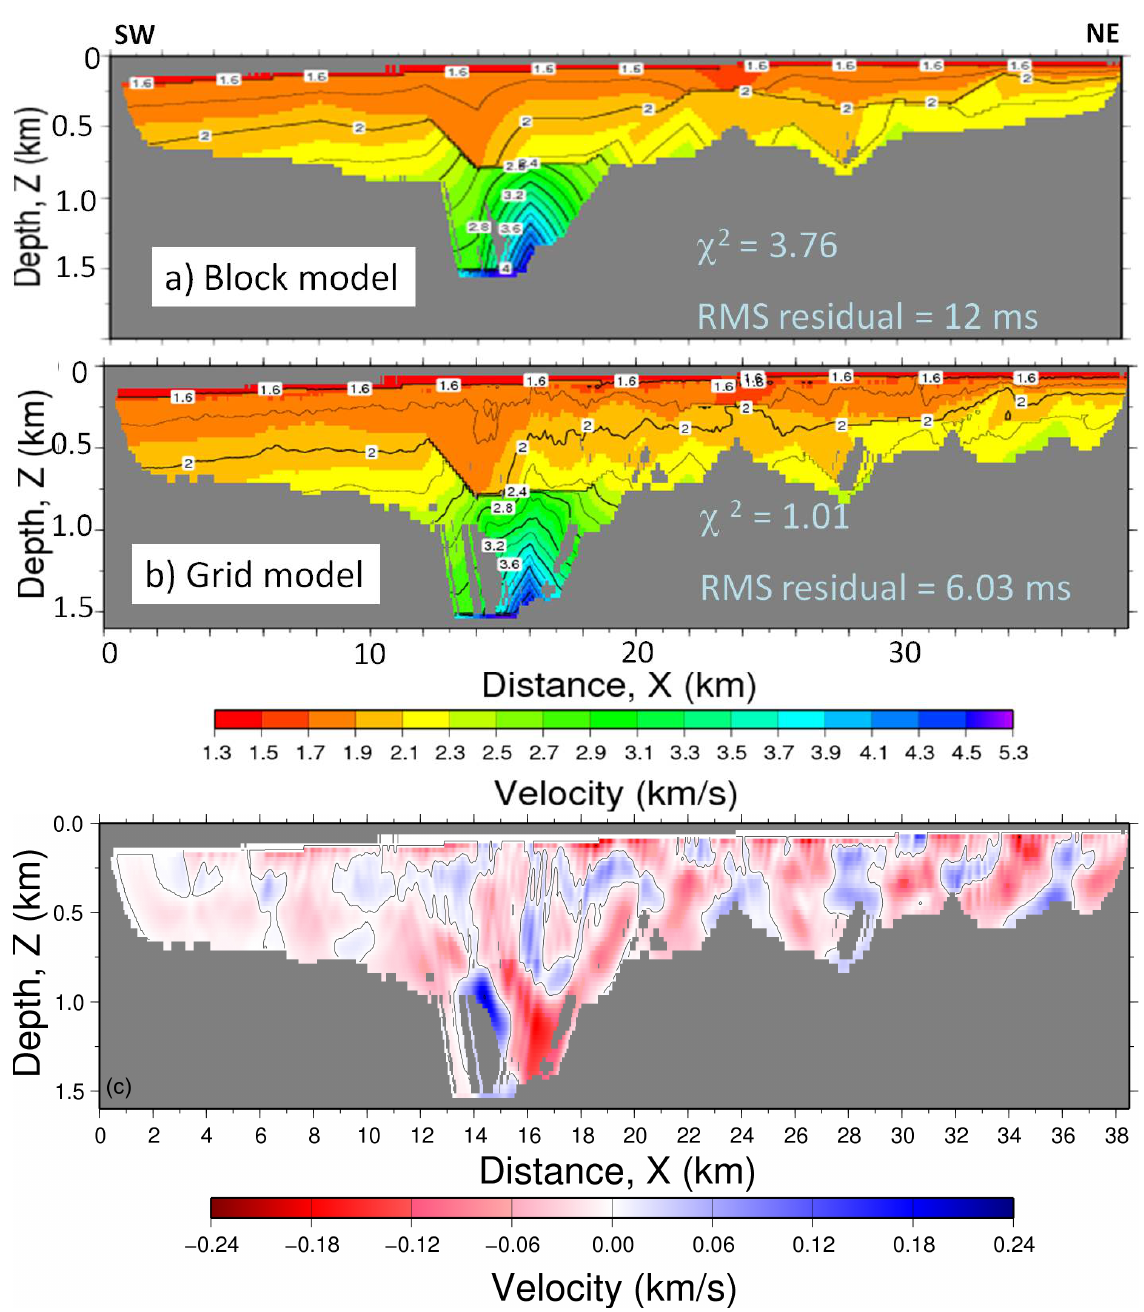
Figure 5. Travel time velocity model from ( a ) block model and ( b ) fine grid model. ( c ) Velocity anomaly obtained by subtracting fine grid model ( b ) from block model ( a